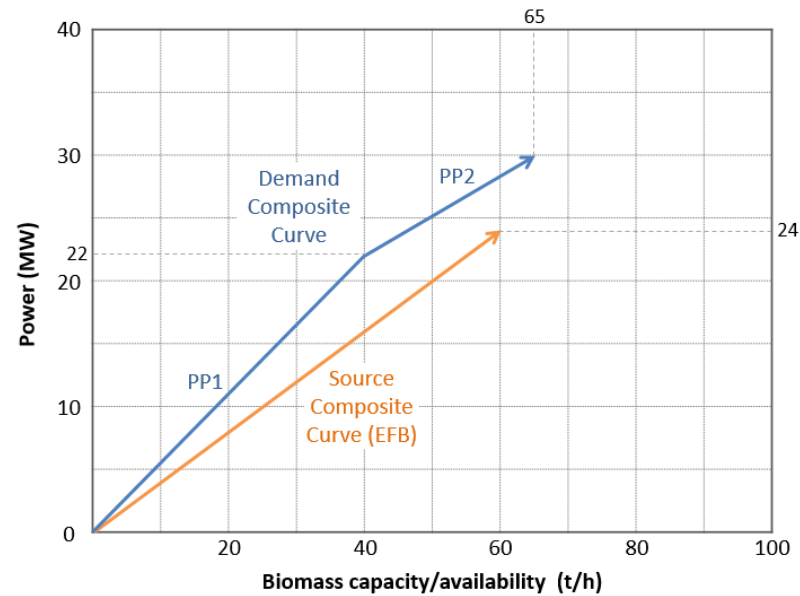
Figure 4. Infeasible BEPD due to insufficient EFB.